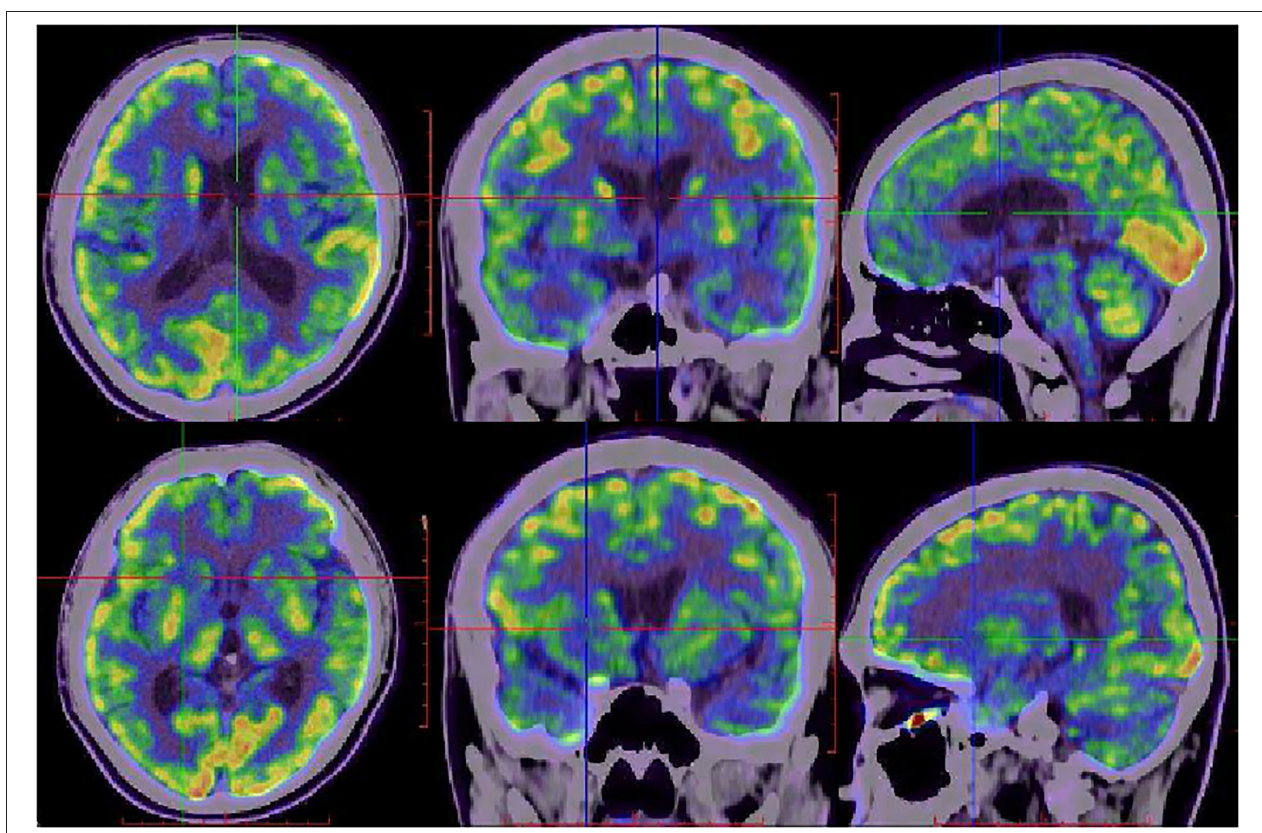
FIGURE 4 | FDG-PET images of the proband at 20 months after onset. FDG-PET showed hypometabolism in bilateral frontal, parietal, temporal lobes, bilateral caudate nucleus, putamen, and thalamus, with right lateralized basal ganglia hypometabolism.